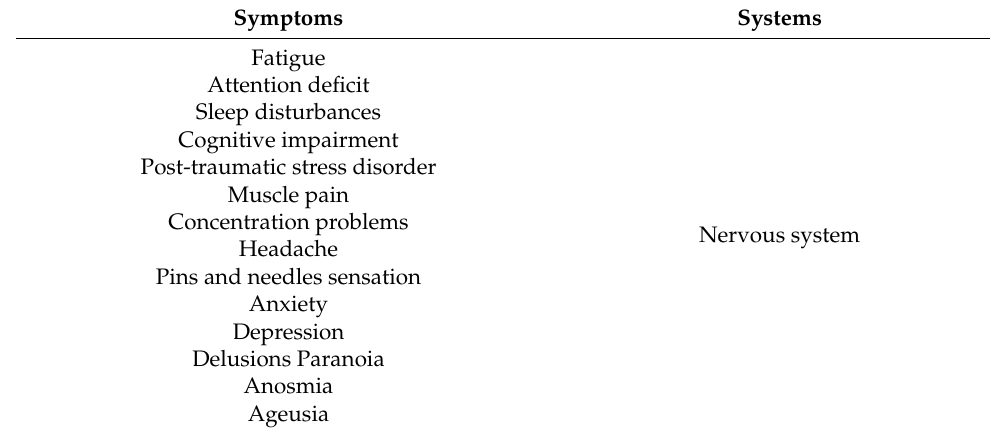
Table 1. Summary of symptoms associated with long COVID and their related